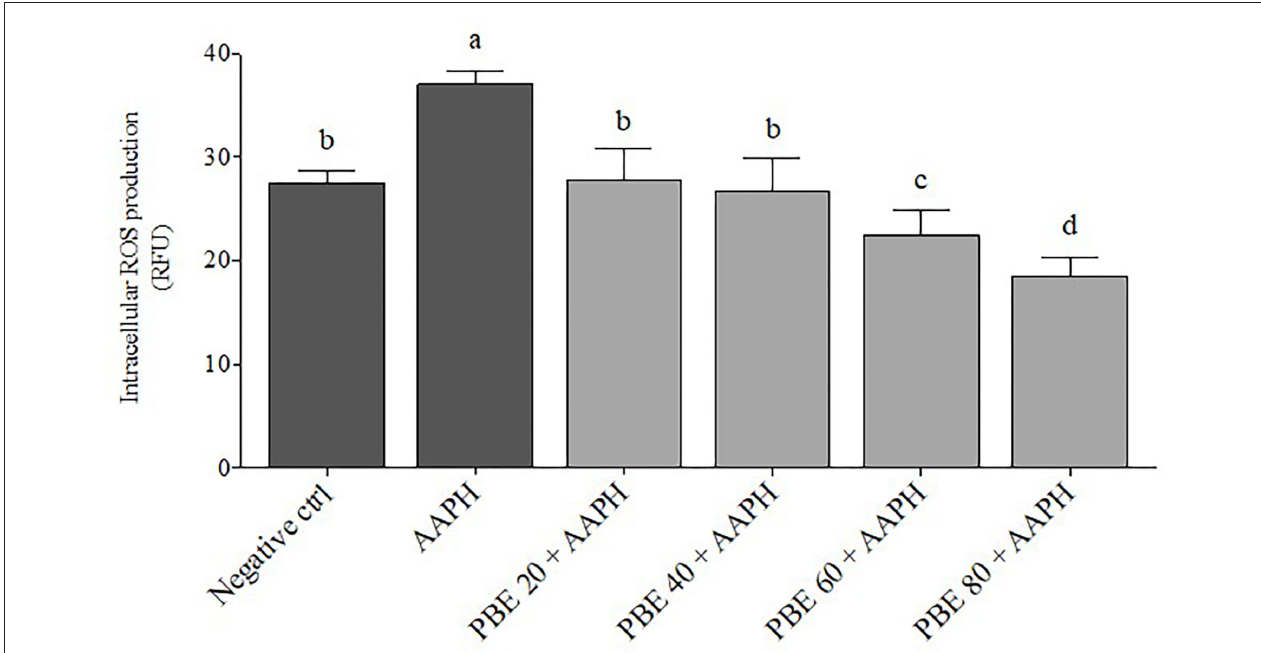
FIGURE 2 | Mean changes in bovine aortic endothelial cell production of reactive oxygen species (ROS) after exposure to different concentrations of pomegranate by-product extract (PBE) and AAPH, expressed as relative fluorescence unit (RFU). Dark gray bars represent the mean of controls; negative control is untreated cell and AAPH treatment. Light gray bars represent different treatments (PBE 20 = pomegranate 20 µ g/ml, PBE 40 = pomegranate 40 µ g/ml, PBE 60 = pomegranate 60 µ g/ml, PBE 80 = pomegranate 80 µ g/ml). Different letters ( a − d ) represent significant difference ( p < 0.05). Error bars represent SEM.